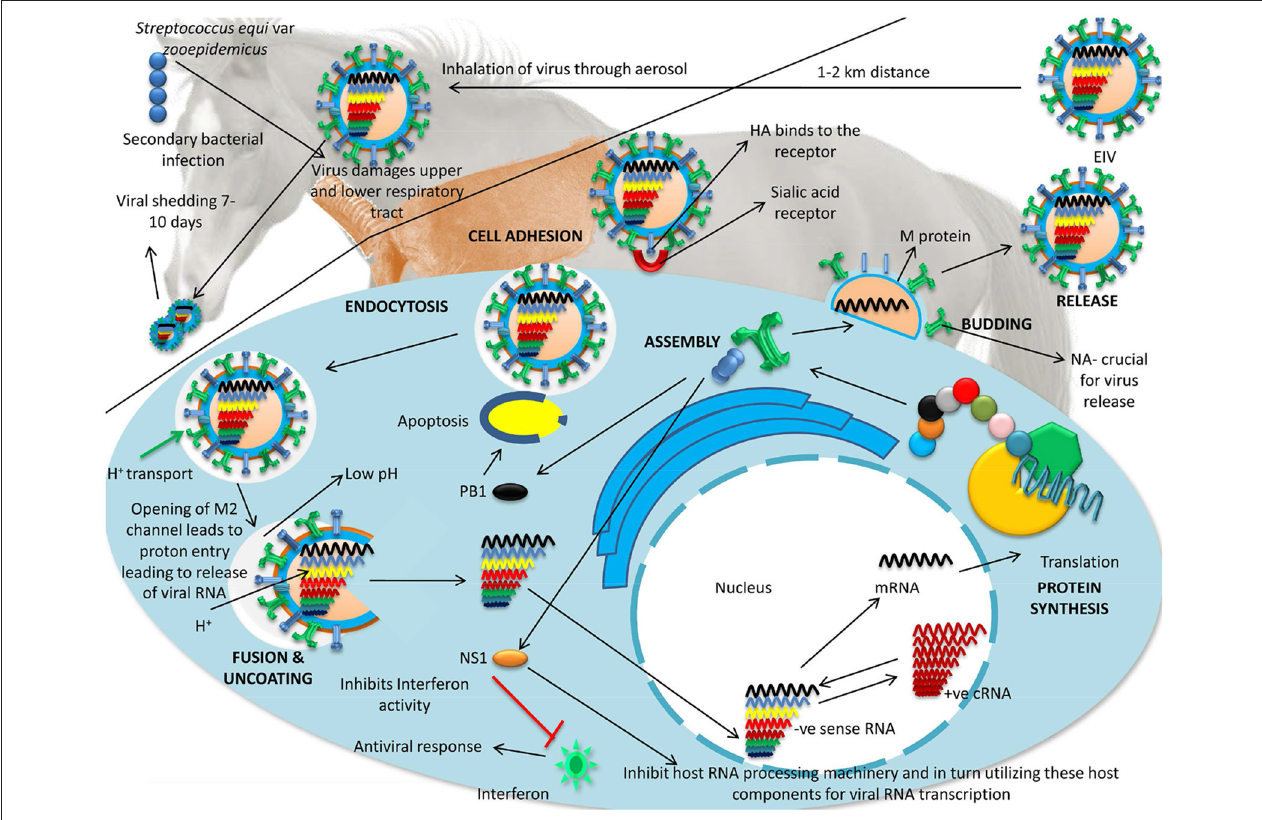
FIGURE 4 | Replication and pathogenesis of EIV. EIV damages the upper and lower respiratory tract’s ciliated epithelial cells thereby causes inability to clear foreign substances. Spike glycoprotein HA fastens to the receptors present on the respiratory epithelial cells and it enters the cells by endocytosis. After endocytosis, EIV undergoes fusion and uncoating. Opening of M2 channel leads to proton entry and subsequent release of viral RNA followed by synthesis of viral structures leading to assembly of EIV. EIV is released from the infected cells by the process of budding.